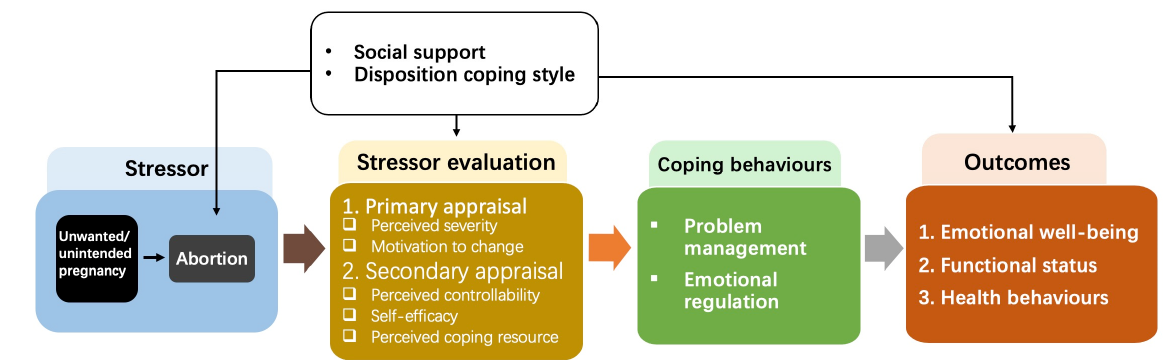
Figure 1. The Transactional Model of Stress and Coping.